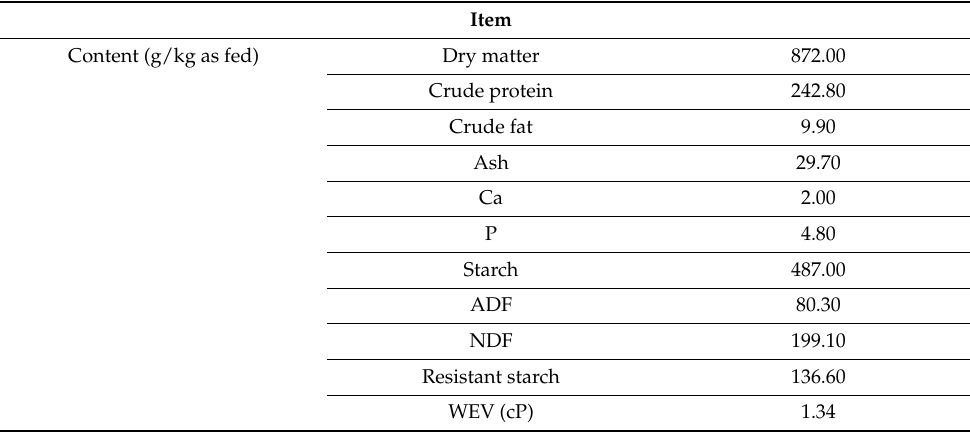
Table 1. Chemical composition, amino acids profile, NSP content, and antinutritional factors 1